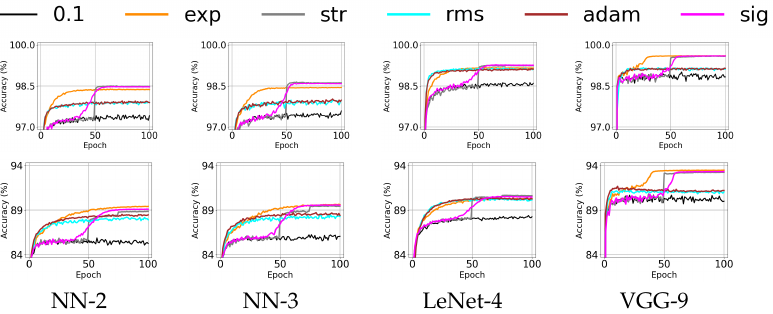
Figure 2. Shallow model with learning rate decay. Accuracy curve over epochs for MNIST ( top row ), and Fashion-MNIST ( bottom row ) by SGD with different learning rate annealings: constant learning rate η = 0.1, exponential (exp), staircase (str), RMSprop (rms), Adam (adam), and sigmoid (sig): The per-epoch average of validation accuracy over 10 trials is shown in the y-axis where the range of accuracy is fixed for each data-set. Epoch (0, 1, 2, ..., 100) is shown in the x-axis.